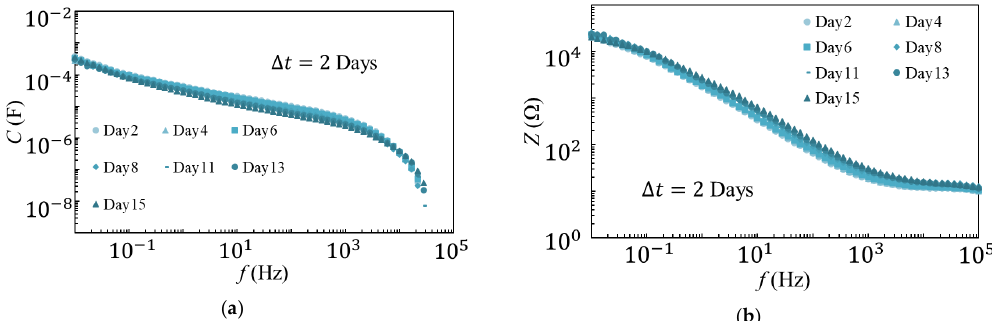
Figure 7. C ( a ) and Z ( b ) measured at 5 °C in variable temperature (80–5 °C) degradation tests.